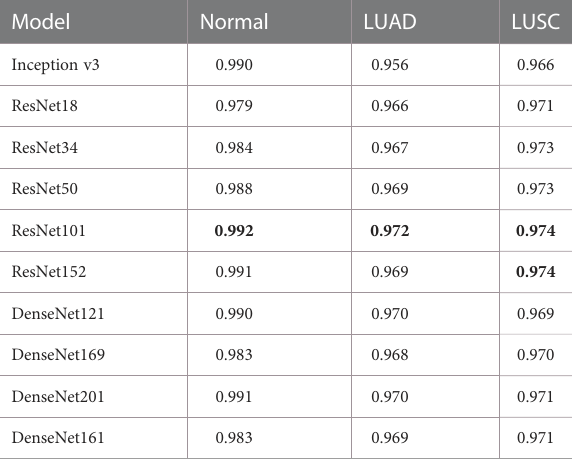
Bold font indicates best result obtained for